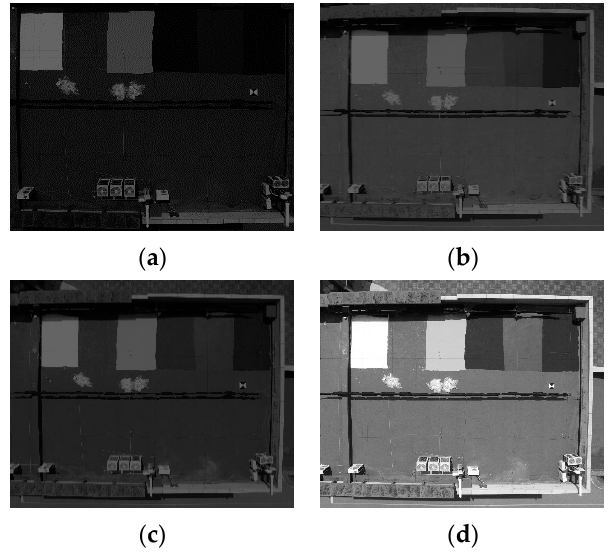
Figure 6. Image processing result obtained from the color space technique application: ( a ) LRV; ( b ) HSV (V channel); ( c ) HSL (L channel); and ( d ) YUV (Y channel).